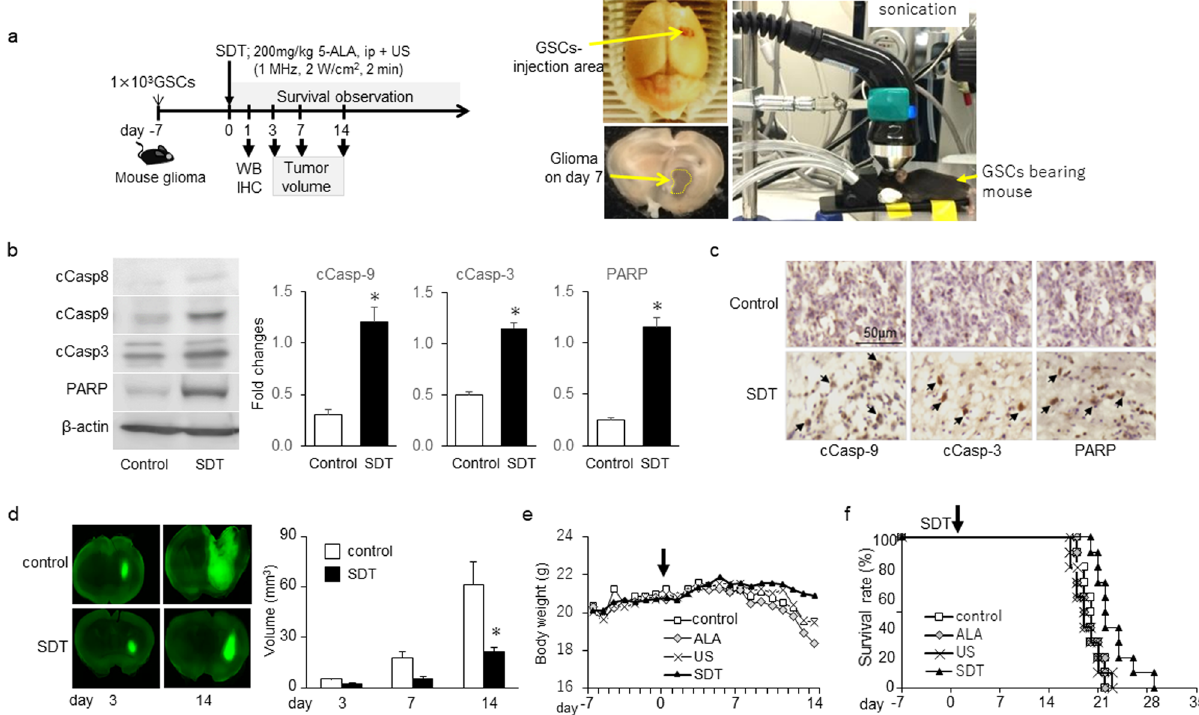
Figure 2. Anti-tumor effects of SDT in the mouse GSC-bearing glioma model. ( a ) Protocol in mouse GSC- bearing glioma model; SDT performed 7 days after injection of GSCs. The mice subjected to US 1 MHz, 2 W/ cm 2 2 min) at 3 h after injection of 200 mg/kg 5-ALA. Photographs indicate mice subjected to SDT, GSC injection area, and glioma. ( b ) Representative western blot analysis on day 1 after SDT compared to non- treatment control in a GSC-bearing mouse glioma model. Each column indicates mean ± SD (n = 4). * p < 0.05 by Student’s t-test. ( c ) DAB immunohistochemistry of apoptosis-related molecules on day 1 after SDT in a glioma- bearing mouse. Each specimen was co-stained with hematoxylin. Arrows point to positive cells. ( d ) GFP-labeled GSCs and tumor volume in brain on days 3–14 after SDT. Each column data indicates mean ± SD (n = 6). * p < 0.05 by Student’s t-test. ( e ) Changes in body weight before and after SDT. ( f ) Kaplan–Meier survival estimate (%), no significant difference by log-rank test (n =